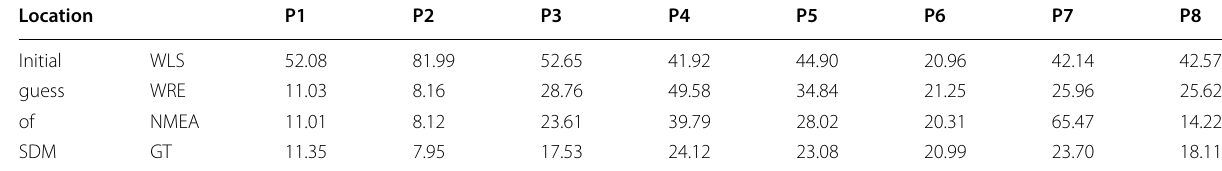
Table 9 The mean error of real satellite visibility based shadow matching initialized by different approaches (m) Location P1